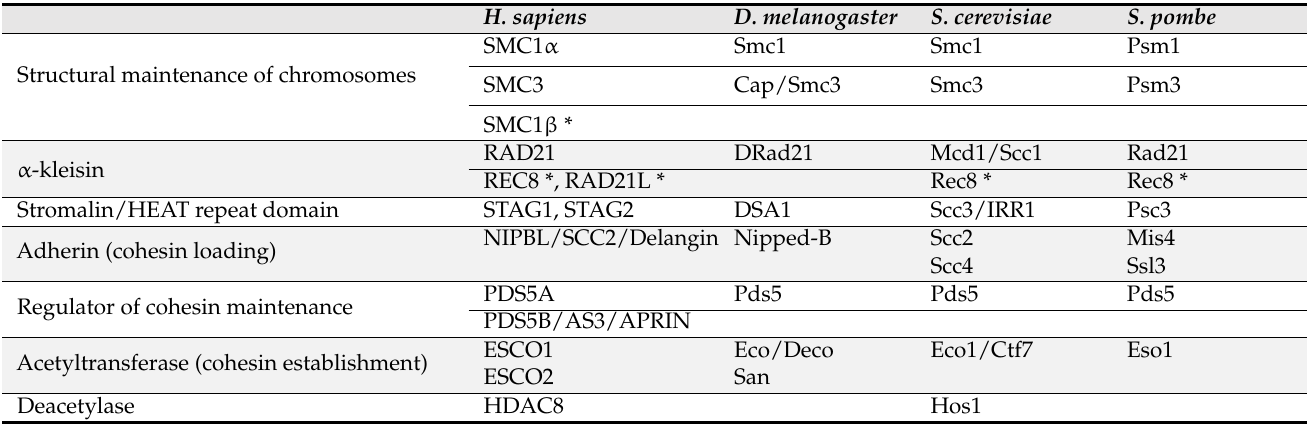
Table 1. Cohesin subunits and cohesin